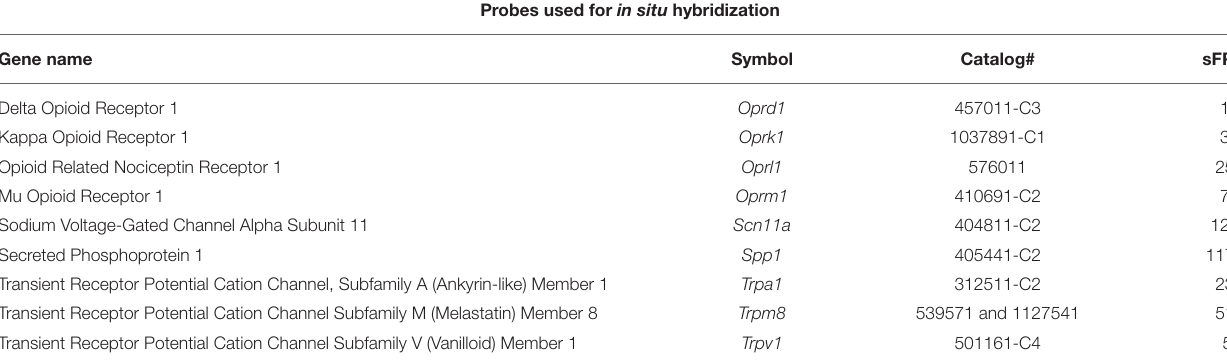
TABLE 1 | Table of genes examined in the present